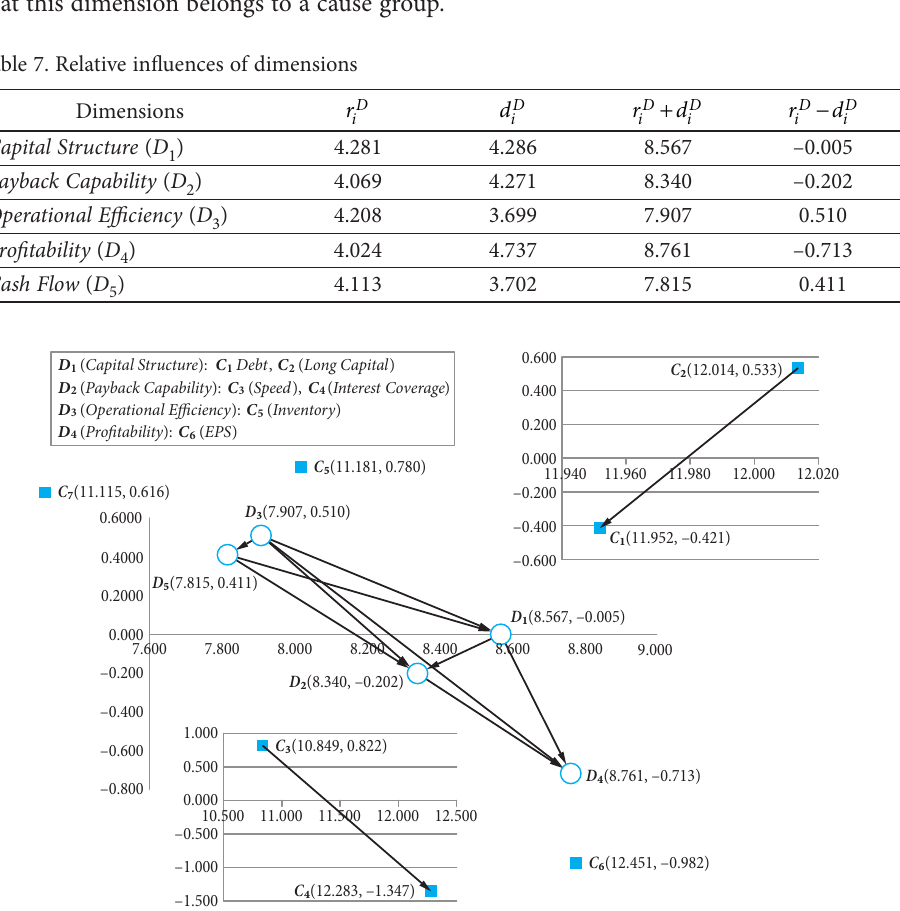
Fig. 4. Influential network relationship map